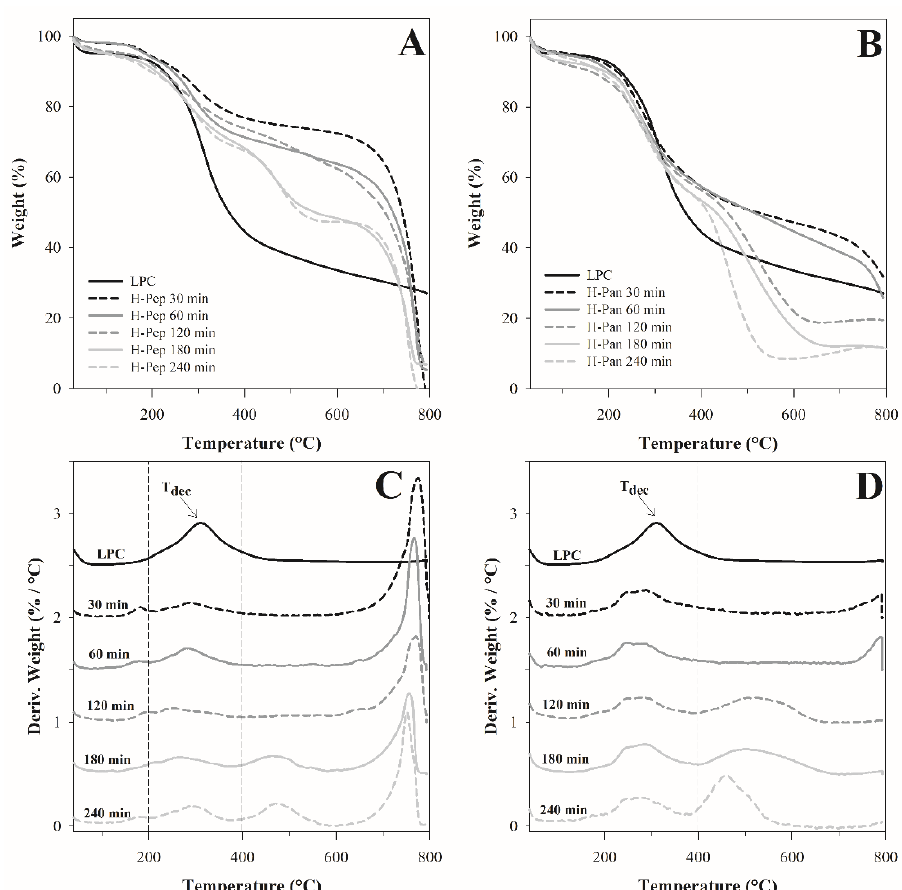
Figure 2. Curves of TGA ( A , B ) and DTG ( C , D ) of leaf protein concentrate (LPC) and protein hydrolysates obtained with pepsin ( A , C ) and pancreatin ( B , D ) at different hydrolysis times. The analysis of the decomposition stages of the LPC and its hydrolysates (Table 3) showed that the moisture content (stage I) in all samples ranged between 1.93–7.94%, with H–Pep being the samples with the ( p < 0.05) lowest moisture content. The low moisture content indicates a lower hydrophilic character [24], which is consistent with the low solubility reported for H–Pep (19–41%) compared to H–Pan (60–98%, [15]). The second weight loss (stage II) of LPC was 61.6% and occurred between 252.4 and 370.4 °C, which coincides with the content of protein in LPC (65.8%) previously reported [15], indicating